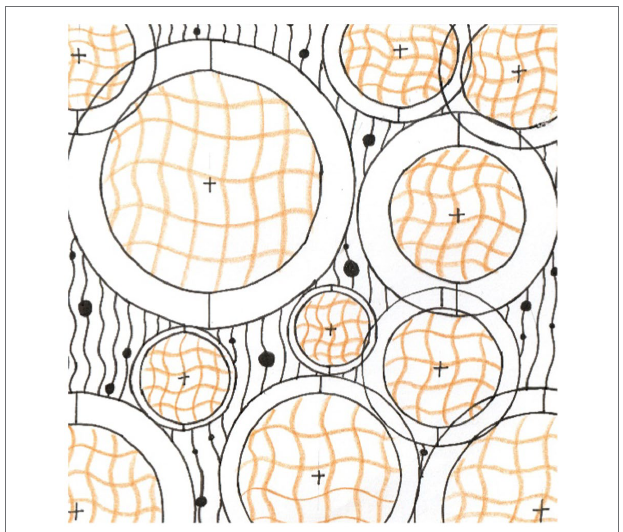
FIGURE 5 | Graphical